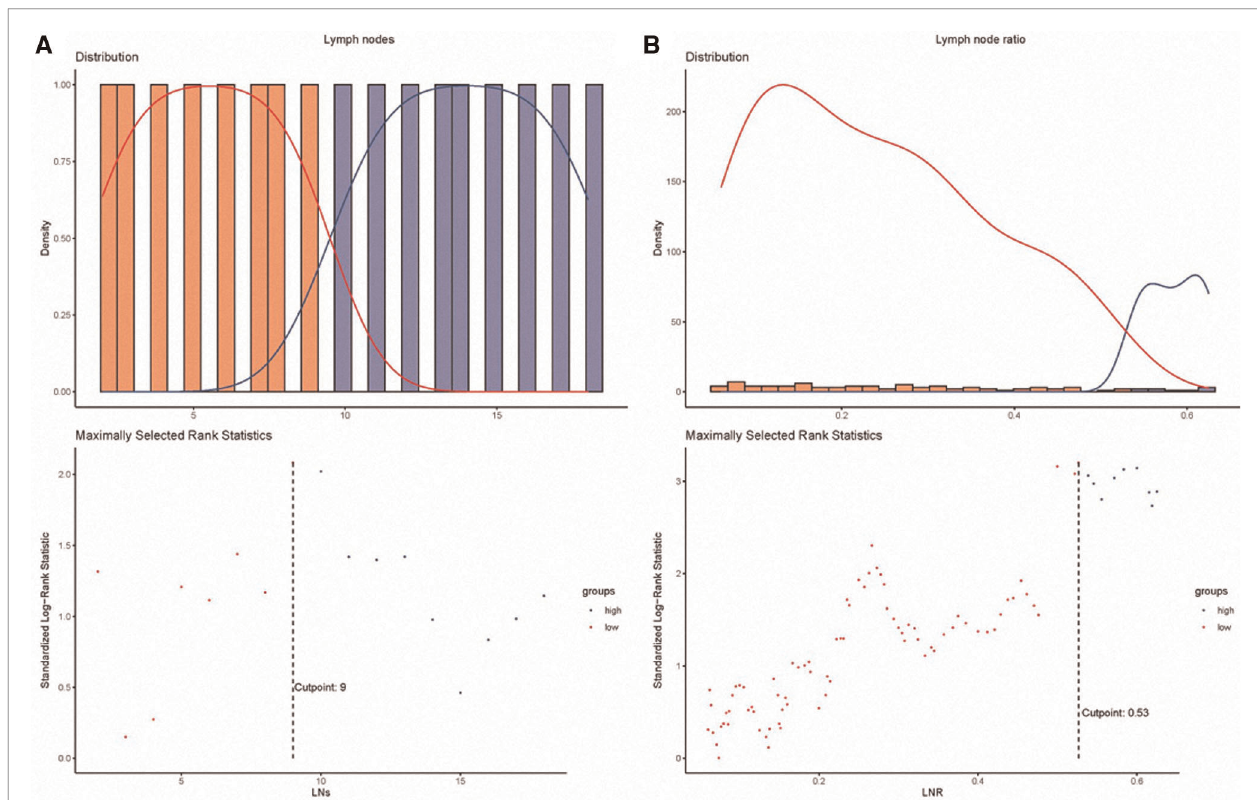
FIGURE 2 | The cutoff value processing for lymph nodes ( A ) and lymph node ratio ( B ). LNs, lymph nodes; LNR, lymph node